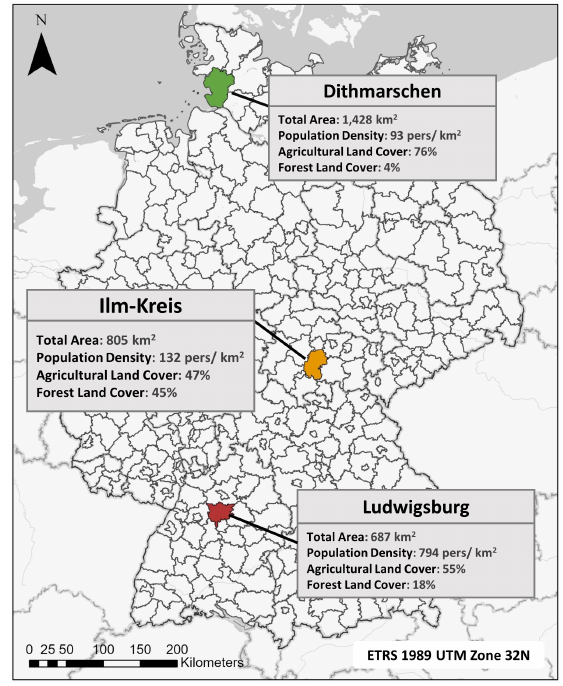
Figure 5. The three selected case study regions in